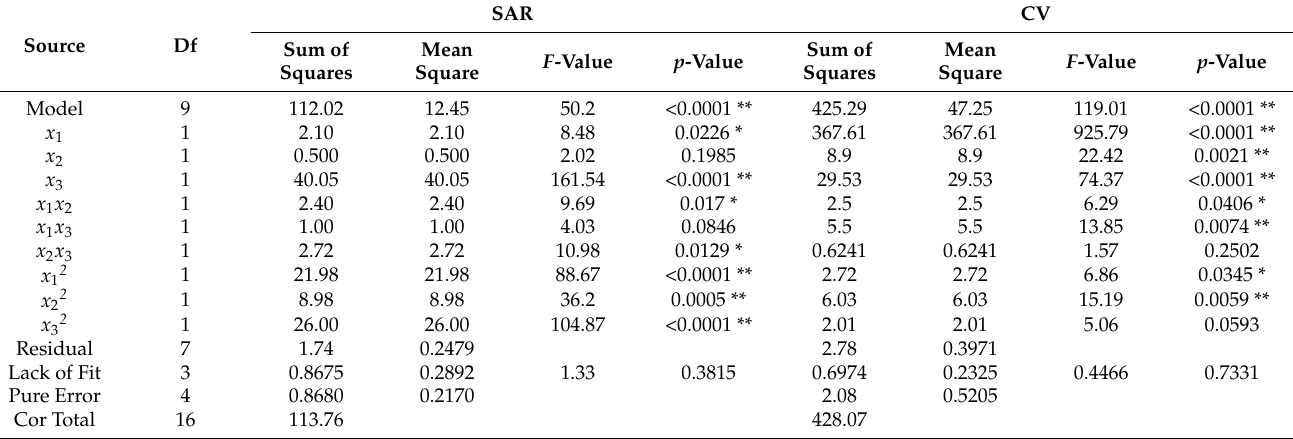
Table 3. Variance analysis of the regression models.